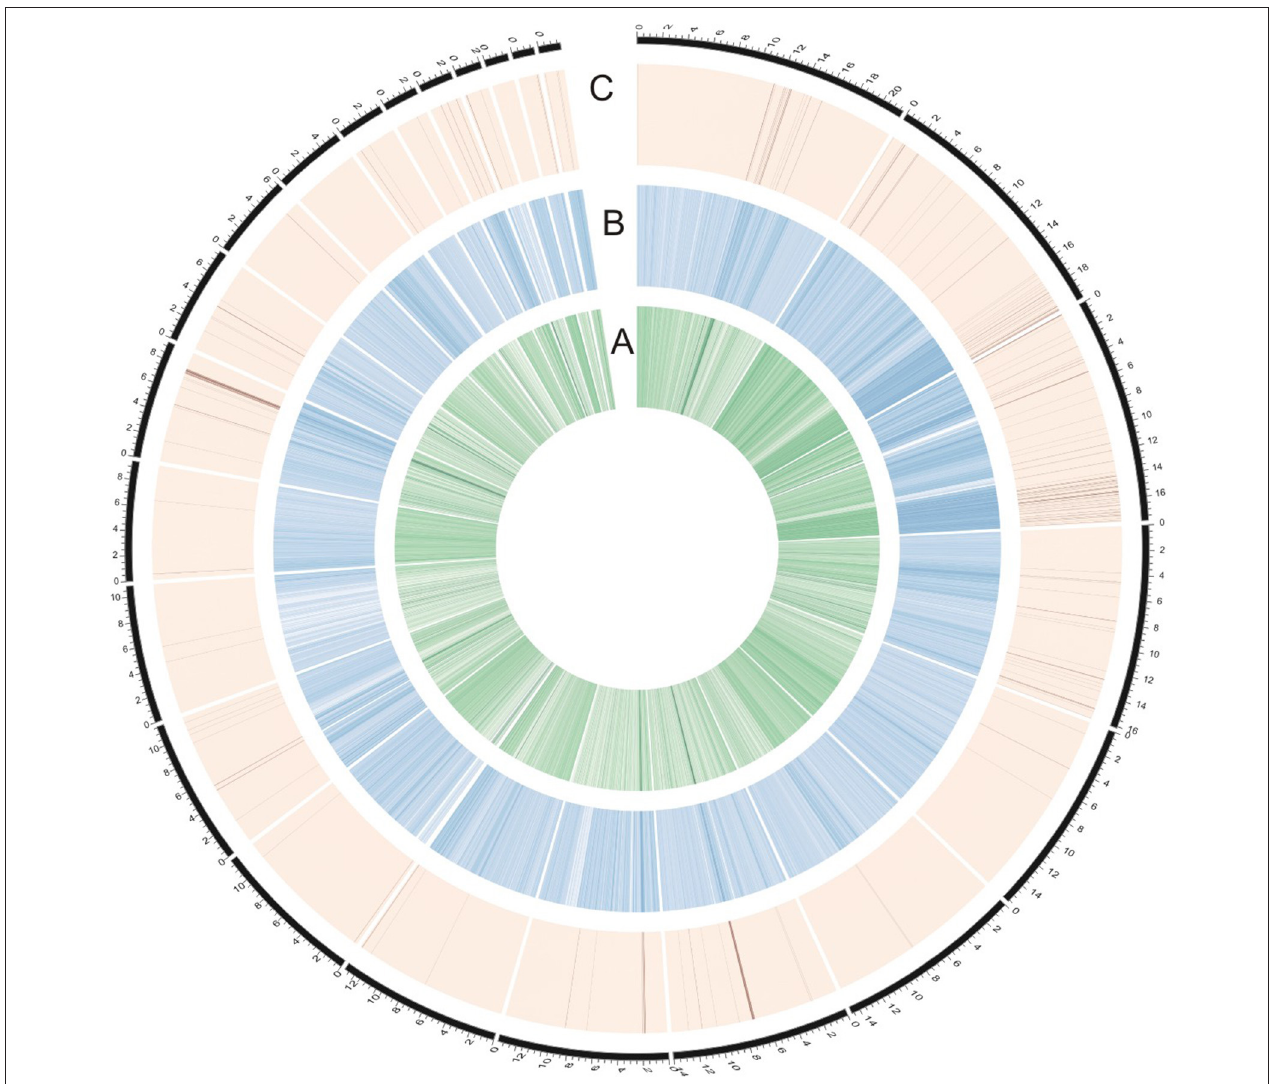
FIGURE 1 | Identification of genomic regions with strong selective sweep signals in salt cress (the entire data). (A) The innermost circle represents θπ (green). (B) The middle circle represents Tajima’s D (blue). (C) The dark lines in the outer circle represents those regions defined as selective sweeps ( θπ ≤ 0.00053 and Tajima’s D ≤ − 1.0197). The outermost dashed black lines indicates 24 major